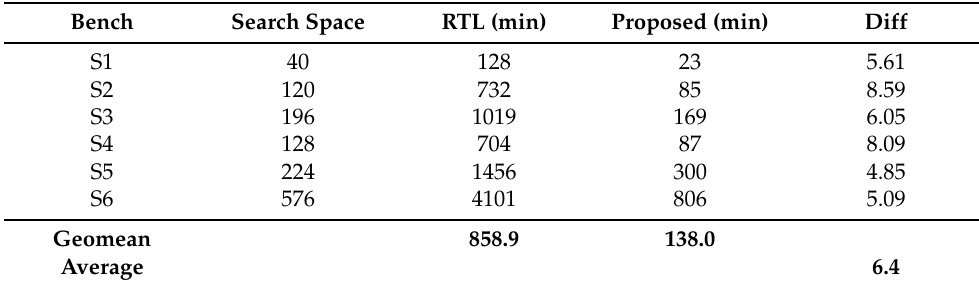
Table 8. System-level DSE running time results